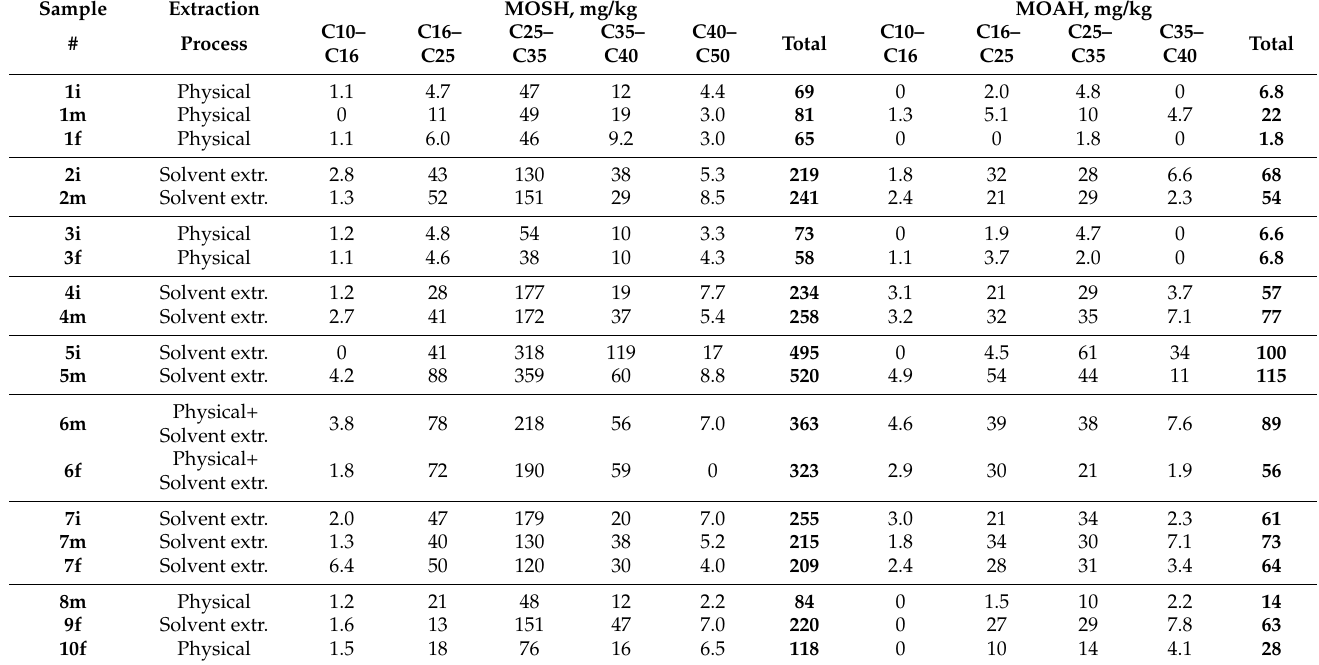
Table 1. Mineral oil saturated hydrocarbon (MOSH) and mineral oil aromatic hydrocarbon (MOAH) content in crude olive pomace oils sampled at the beginning (i), in the middle (m), and/or at the end (f) of the campaign and obtained through physical (centrifugation) and/or solvent extraction means. Results, in mg/kg and with two significant figures, are given for the C-fractions and for the sum of